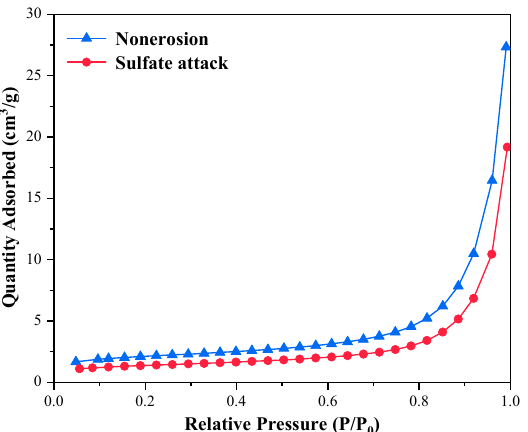
Figure 11. N 2 adsorption desorption isotherm of C 3 S-C 3 A paste under sulfate attack.